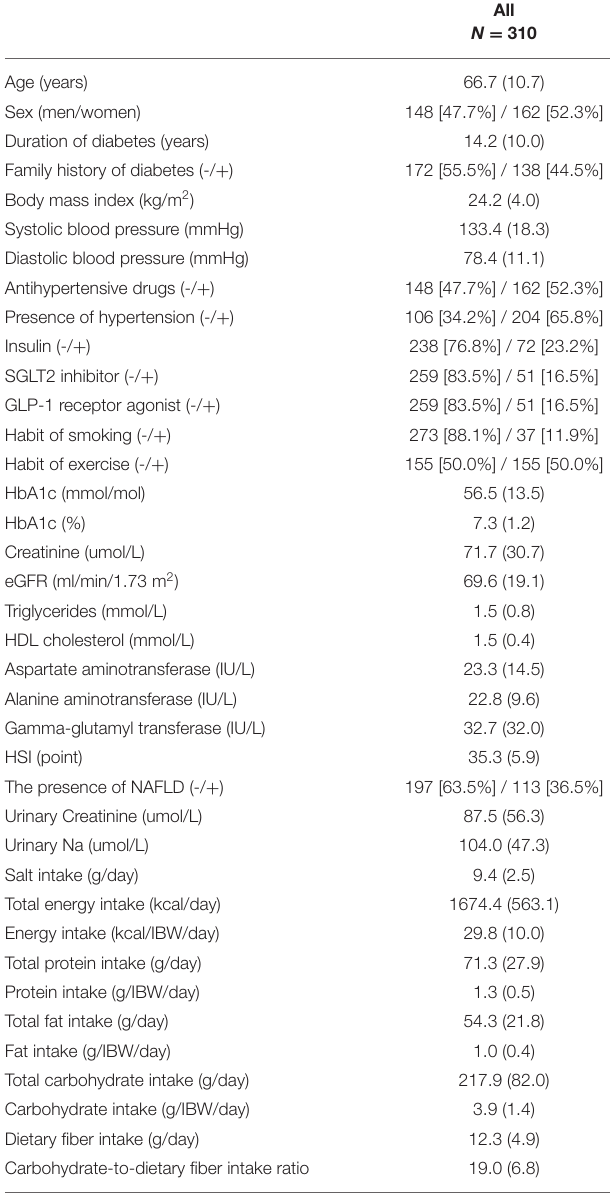
TABLE 1 | Clinical characteristics of study